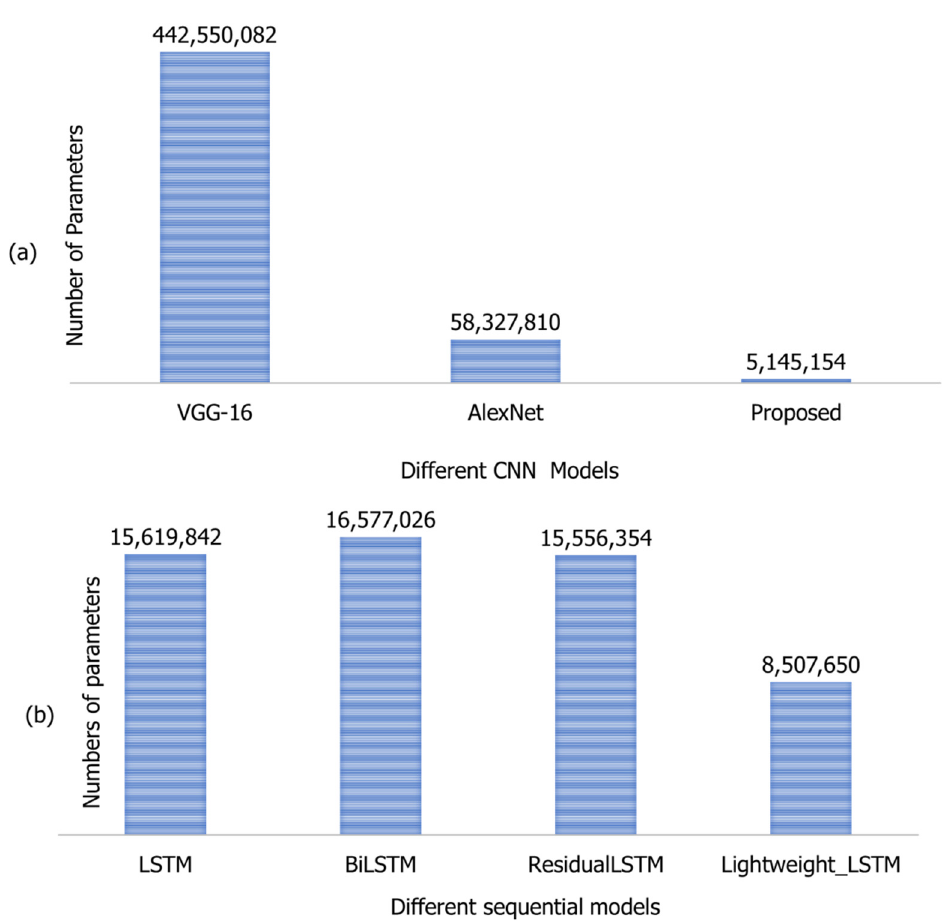
Figure 4. The computational complexity of the models; ( a ) represents the computational complexity of the CNN model, while ( b ) represents the computational complexity of spatio-temporal